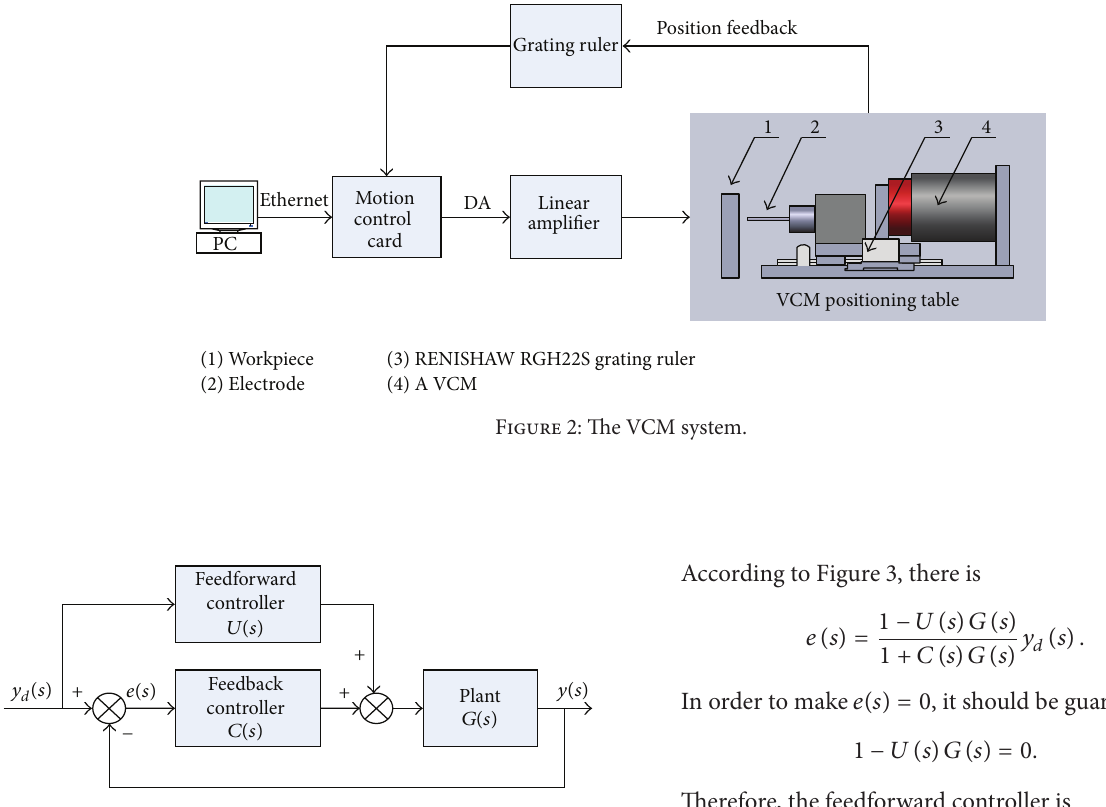
Figure 3: The control